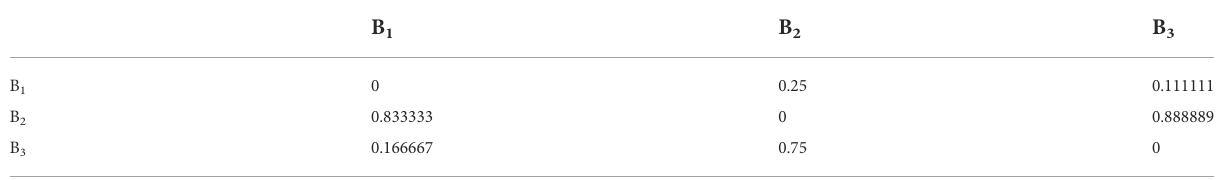
TABLE 3 Unweighted supermatrix.